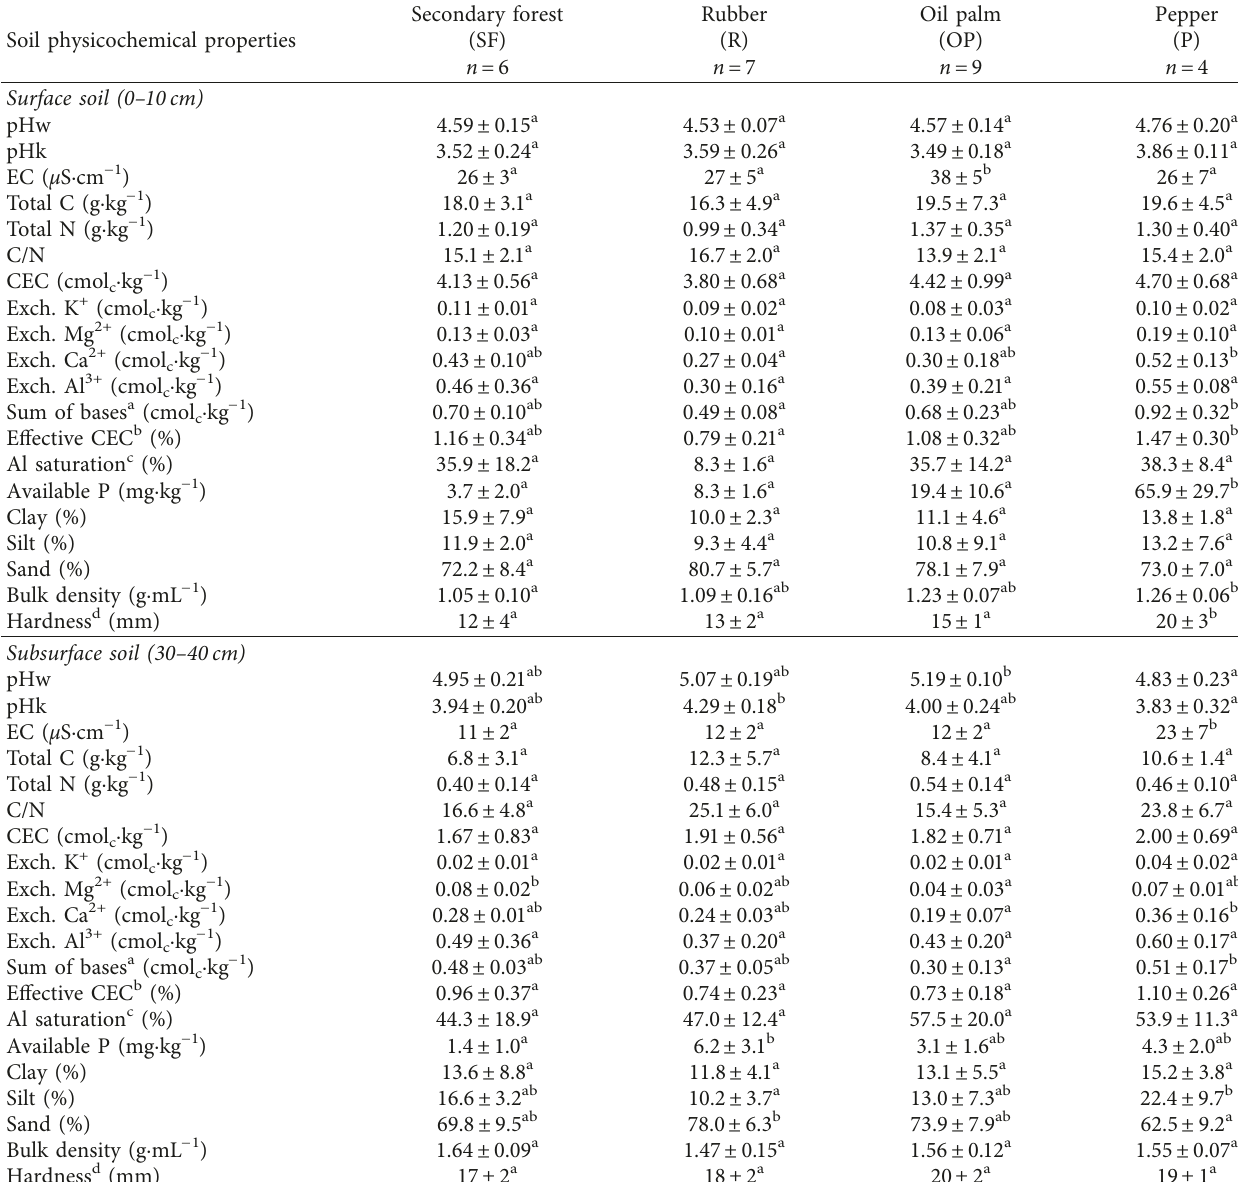
Table 4: Surface and subsurface soil physicochemical properties at various agricultural land uses. Soil physicochemical